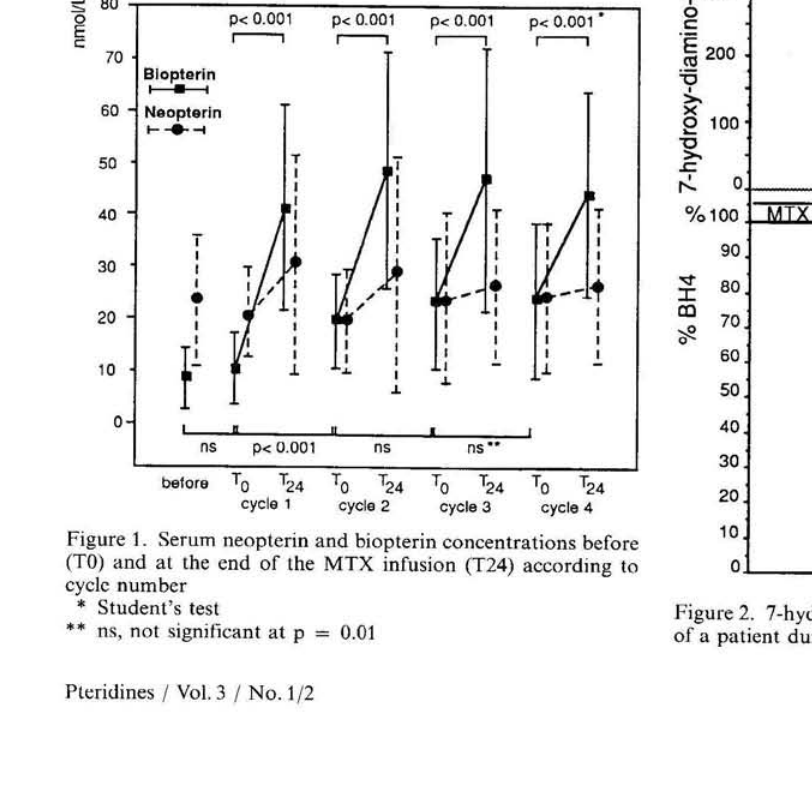
Figure 2. 7-hydroxy-2,4-diamino-pteridines and %BH4inCSF of a patient during HD-MTX